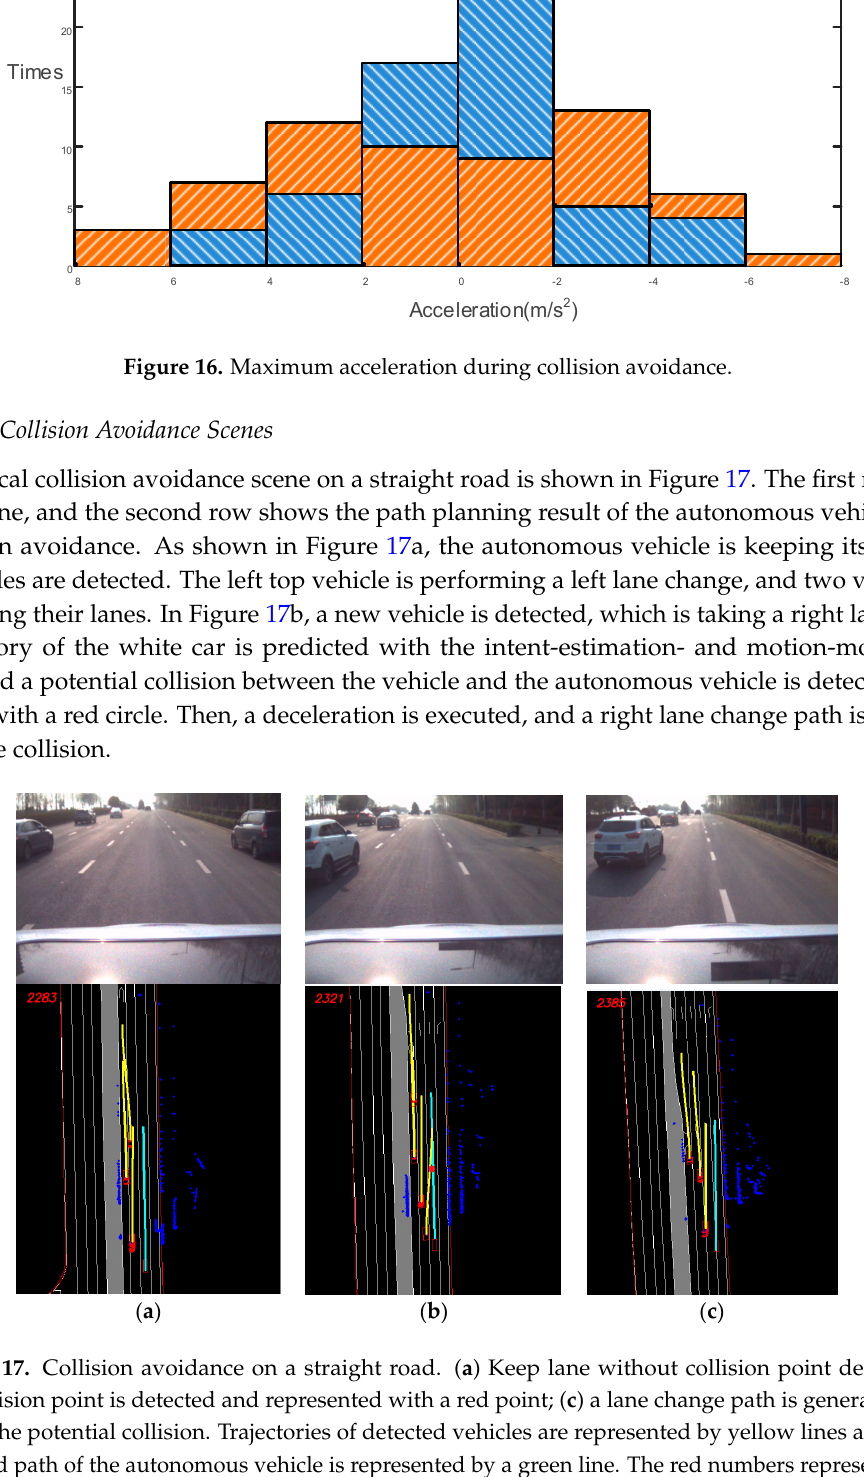
( c ) Figure 18. Collision avoidance on a winding road. ( a ) A collision point is detected; ( b ) decelerate to avoid the collision; ( c ) avoid potential collision successfully. The red number represents the ID of the detected obstacle which is unique.